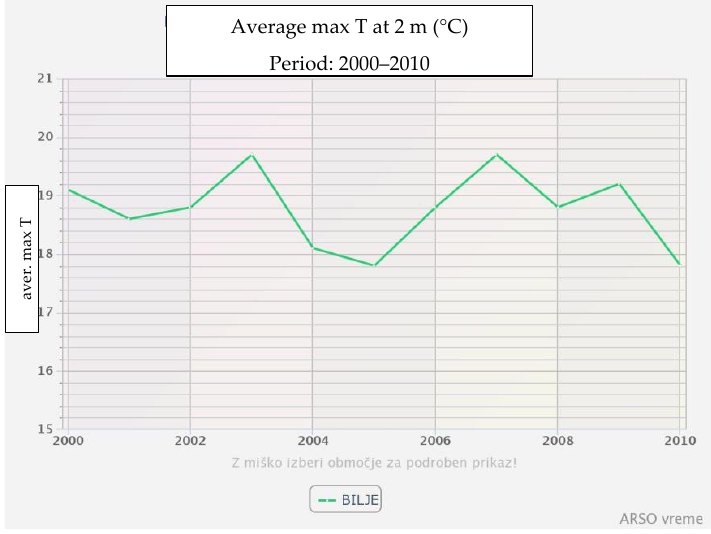
Figure 2. Average maximum temperature for localities 4 — Lijak and 5 — Plave, measured from nearby climate station Bilje (source: https://meteo.arso.gov.si/met/sl/archive, accessed on 27 January 2023).